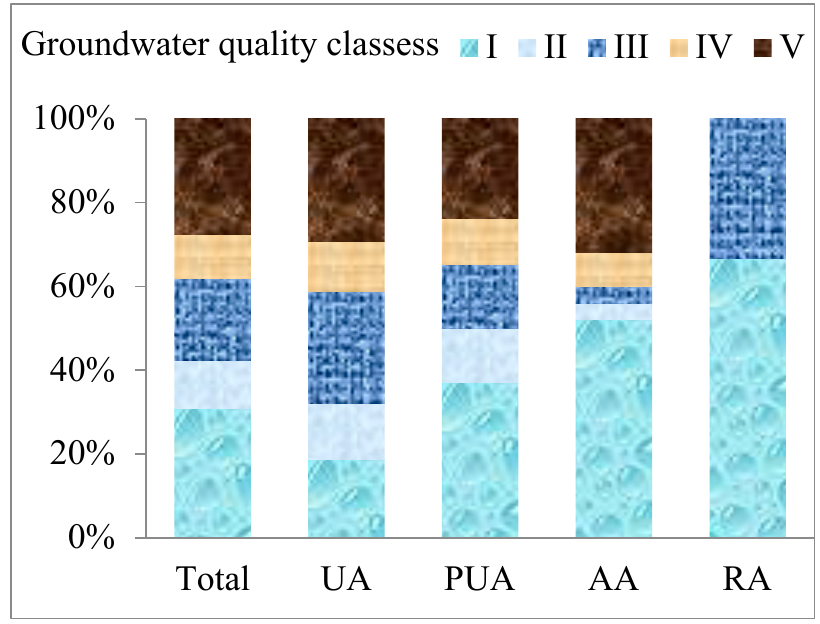
Figure 4. Groundwater quality in areas with different types of land use of the coastal alluvial aq- uifer.